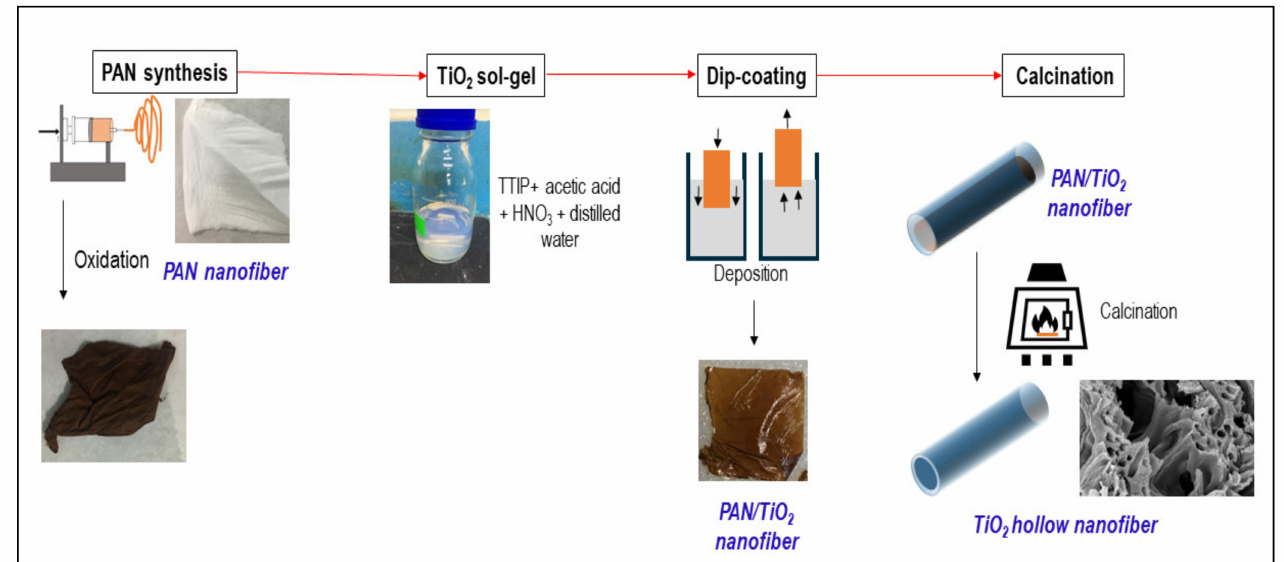
Figure 1. Schematic diagram of titanium dioxide hollow nanofibers development via template